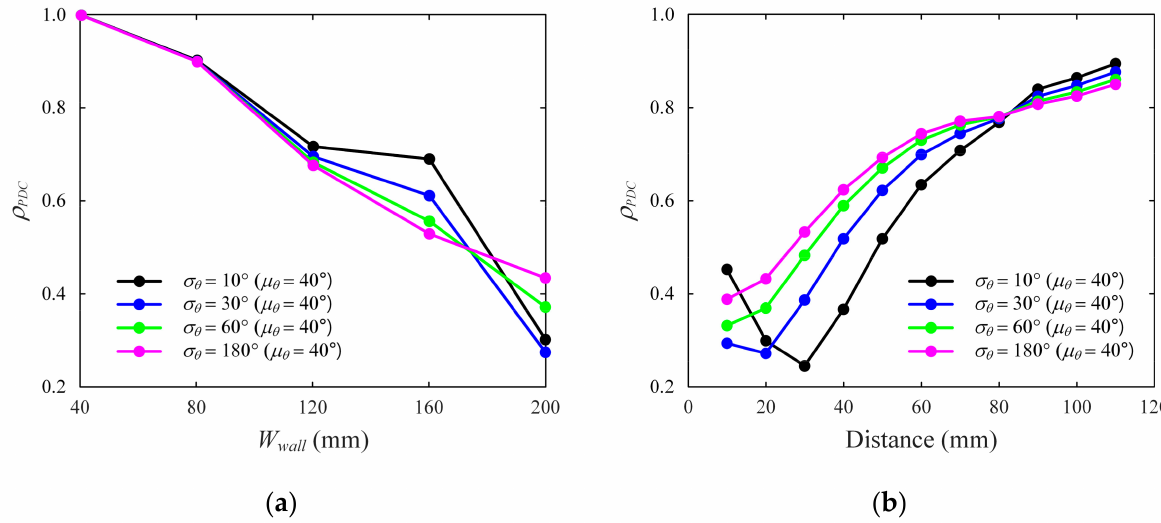
Figure 6. Simulated variation in ρ PDC for IFA according to ( a ) the metallic wall size (distance = 20 mm) and ( b ) distance ( W wall = 200